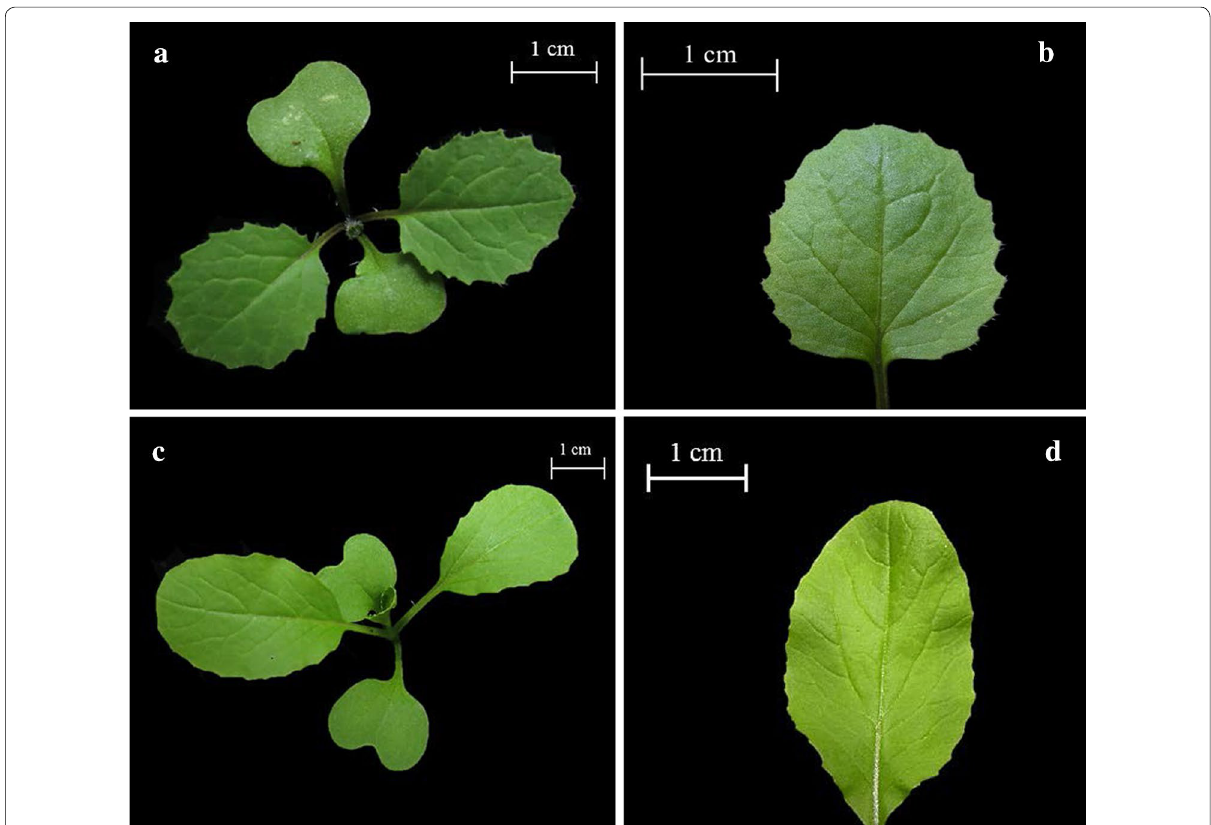
Fig. 2 Two‑leaf stage progenies. a Plant of outcrossing progeny. b Leaf shape of outcrossing progeny. c Plant of nonoutcrossing progeny. d Leaf shape of nonoutcrossing